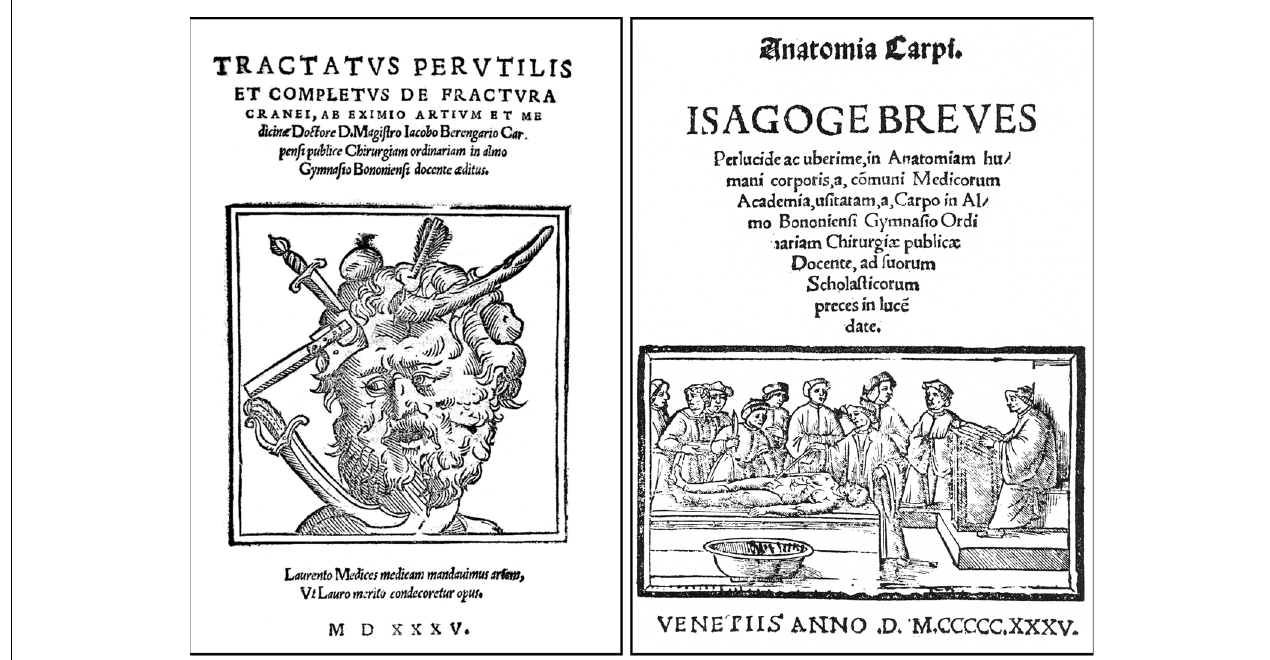
FIGURE 2 | Frontispieces of the Venice 1535 editions of Berengario’s De fractura cranei (left), which was first published in Bologna in 1518, and of Berengarios’s Isagogae breves (right) that first appeared also in Bologna in 1522 (Courtesy of the National Library of Medicine). The typical medieval dissection scene displayed on the title page of the Venetian edition of Isagogae breves is at odds with Berengario’s own involvement in dissection and his insistence on the prominence of observation over authority in anatomy. The very same figure appeared in the frontispiece of other 16th century publications, including works by Galen and